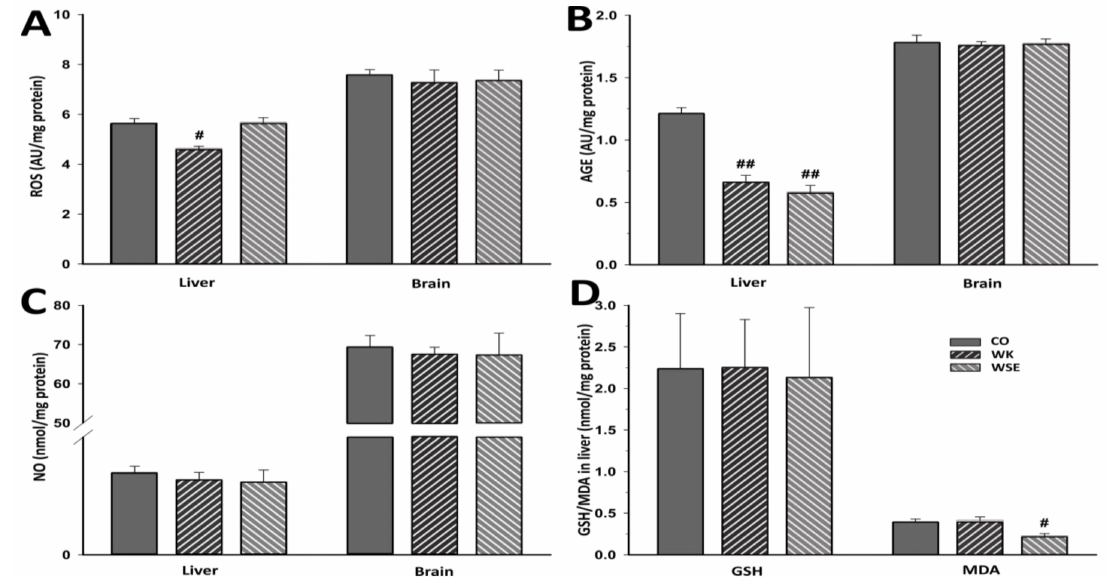
Figure 7. The e ff ects of walnut kernels (WK) and a walnut septum extract (WSE) on oxidative stress biomarkers in naturally aged rats (values expressed as mean ± SD; n = 5); # p < 0.05 and ## p < 0.01 compared to CO (AGE – advanced glycation end products; CO—control old; GSH—total glutathione; MDA—total malondialdehyde; NO—total nitric oxide; ROS—reactive oxygen species). ( A ) ROS; ( B ) AGE; ( C ) NO; ( D ) GSH / MDA in liver.